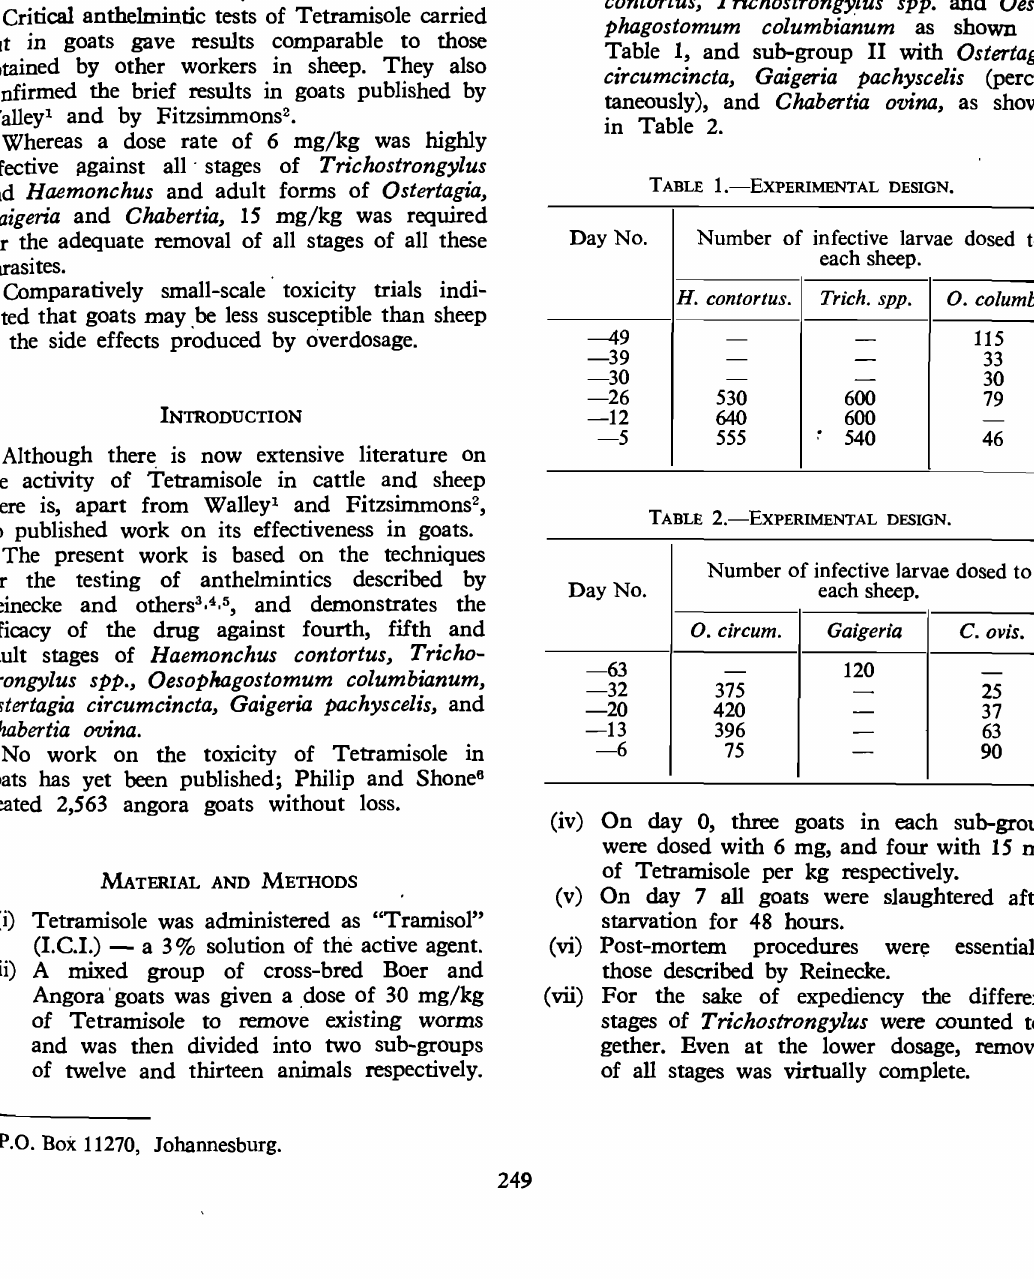
Table 1, and sub-group II with Ostertagia